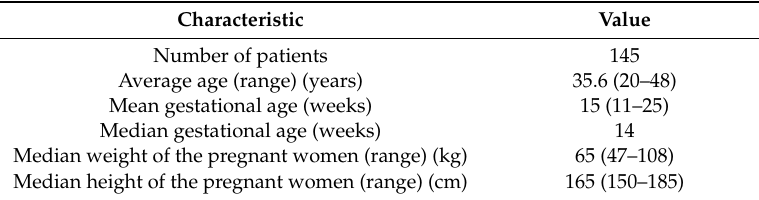
Table 1. Clinical and demographic characteristics of the sampled